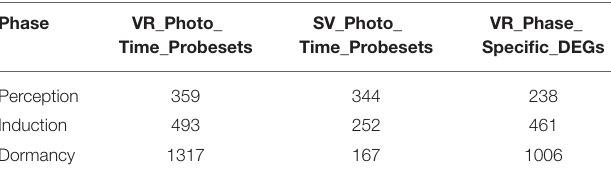
TABLE 1 | Number of differentially expressed genes (DEGs) categorized in perception, induction and dormancy phases of